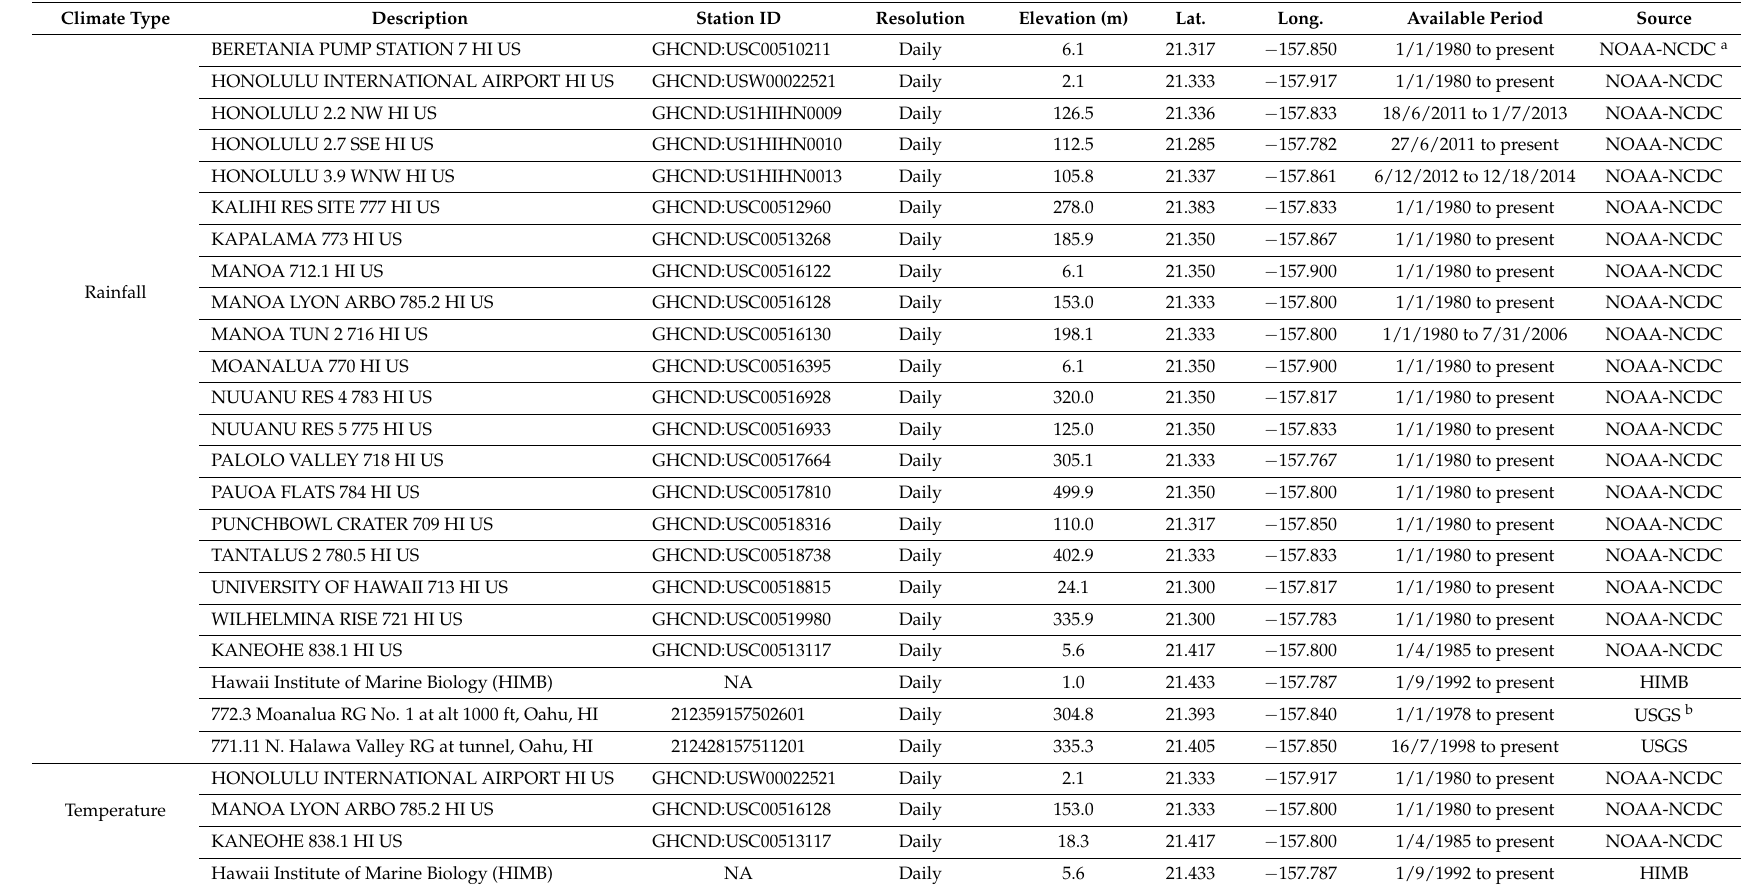
Table 1. Meteorological stations of SWAT for Heeia and Nuuanu area